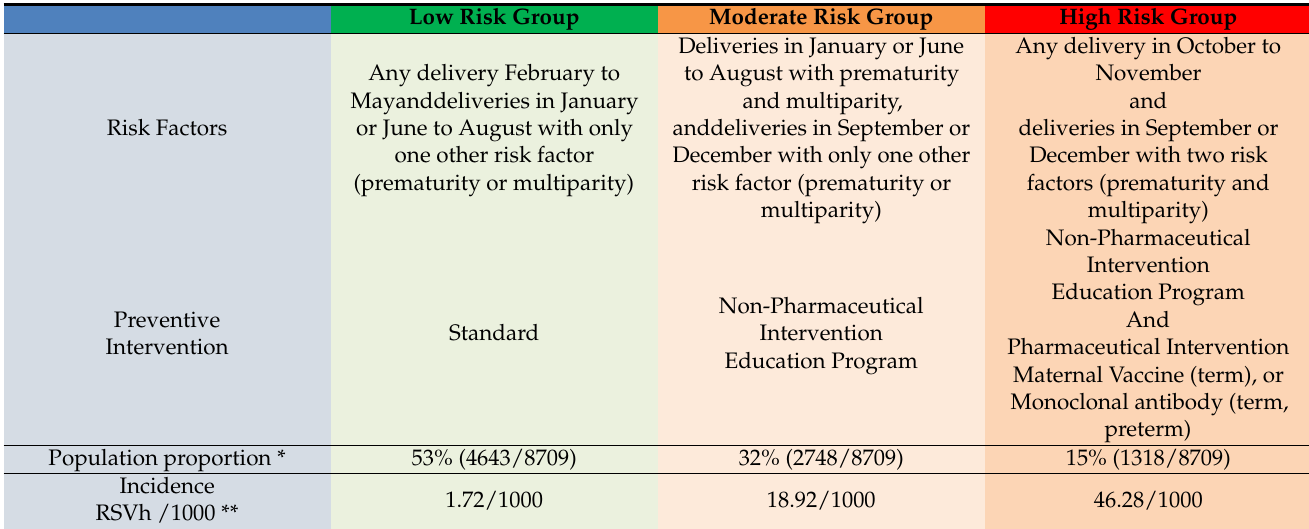
Table 3. Characteristics of the low-, moderate-, and high-risk groups according to the predic- tive